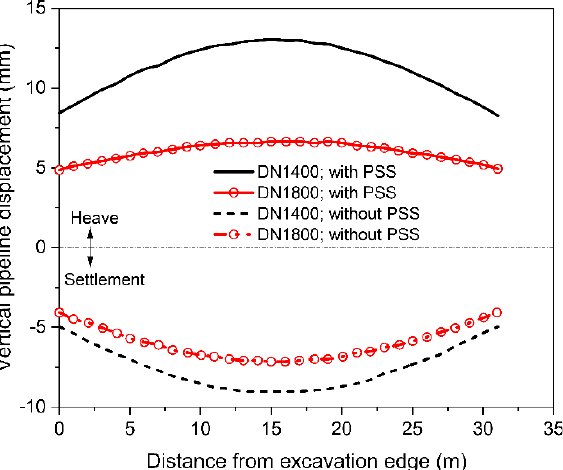
Figure 14. Comparison of vertical displacements of pipelines between cases with and without in- stalling pipeline suspension structure (PSS).